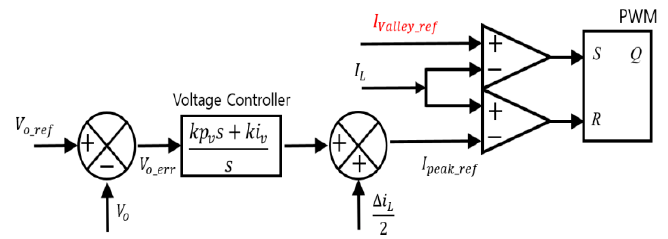
Figure 14. Proposed hybrid current mode control block diagram.